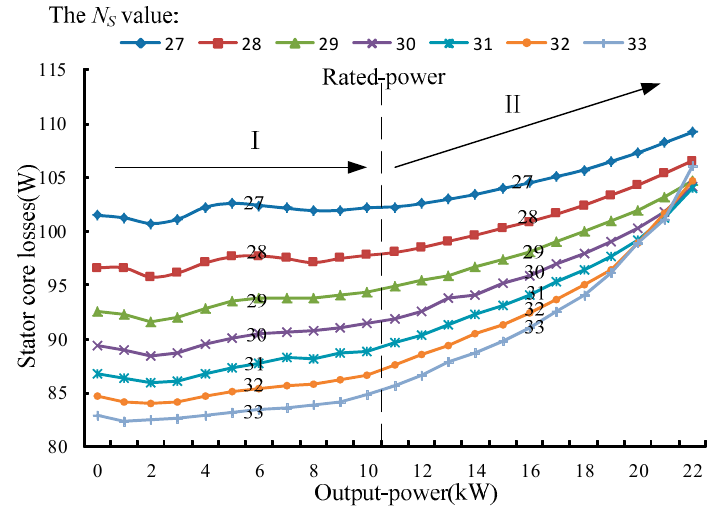
Figure 13. Stator core losses versus load power.